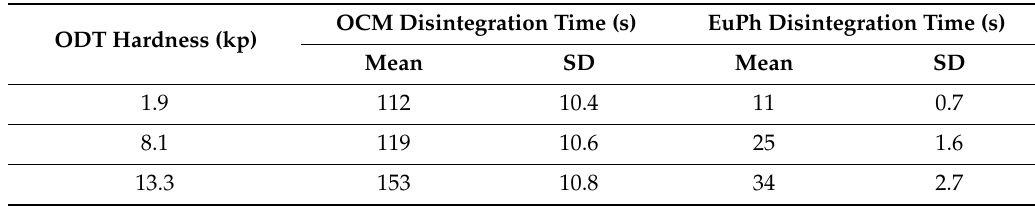
Table 1. Orodispersible tablets (ODT) oral cavity model (OCM) and European Pharmacopoeia (EuPh) mean disintegration times ( n =